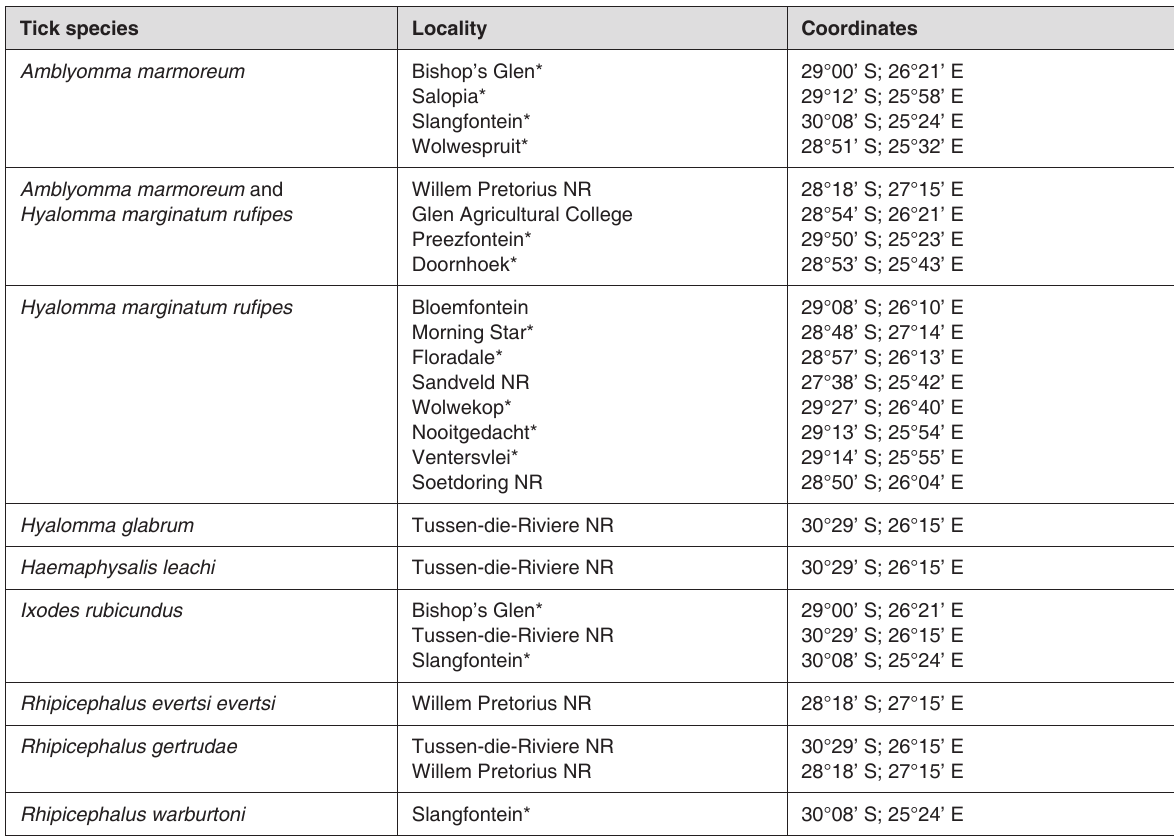
TABLE 1 Localities in Free State Province at which ticks were collected from